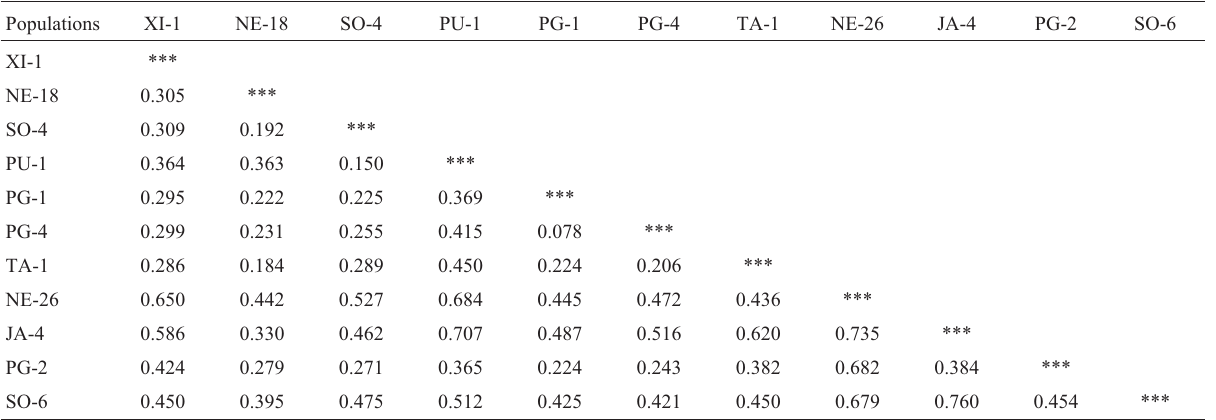
Table 6 - Nei’s (1978) standard genetic distances between eleven Brazilian Oryza glumaepatula populations. Populations XI-1